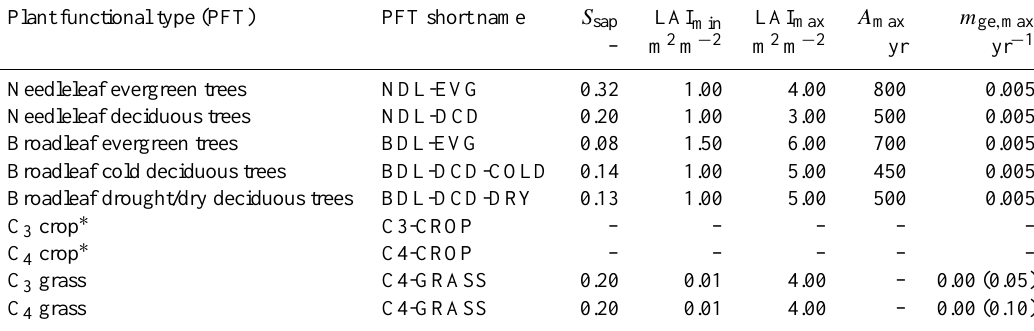
Table 1. Parameters used in the competition module of CTEM v. 2.0. S sap is the multiplying factor for converting biomass density to sapling density (Eq. 15 in Sect. 2.1.2). LAI min is the minimum LAI below which a PFT does not expand and LAI max is the maximum LAI above which a PFT expands at a maximum rate (Eqs. 17 and 18; Sect. 2.1.2). A max is the PFT maximum age, which is used in the calculation of intrinsic mortality (Eq. 20; Sect. 2.1.3). m ge , max is the maximum growth-related mortality used in Eq. (21) for calculating growth-related mortality. Some parameter values differ between the model versions when PFTs’ fractional coverage is specified and when they are dynamically modelled using competition between PFTs. If modified, the parameter values for the dynamically modelled version are shown in parentheses. Plant functional type